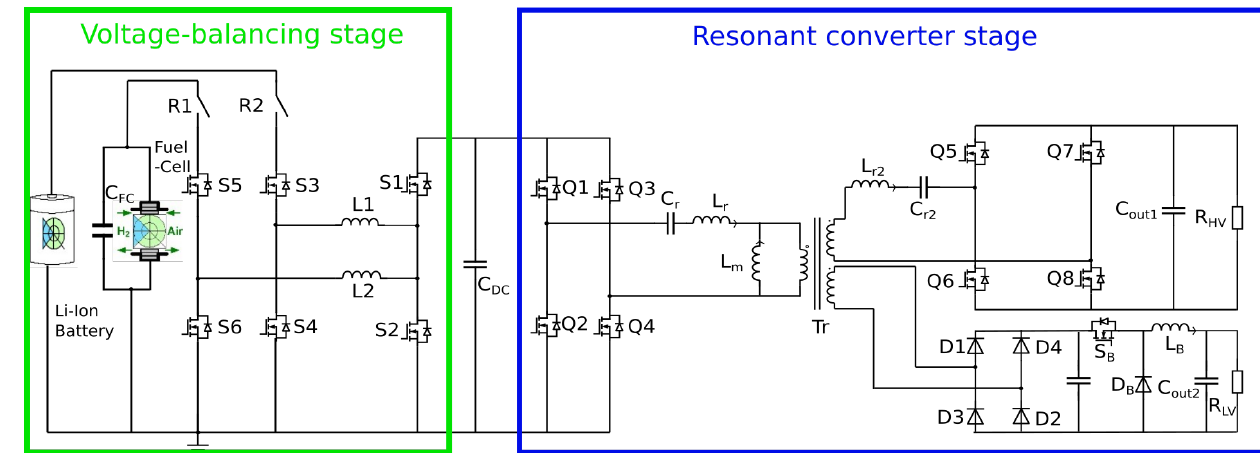
Figure 4. Proposed converter